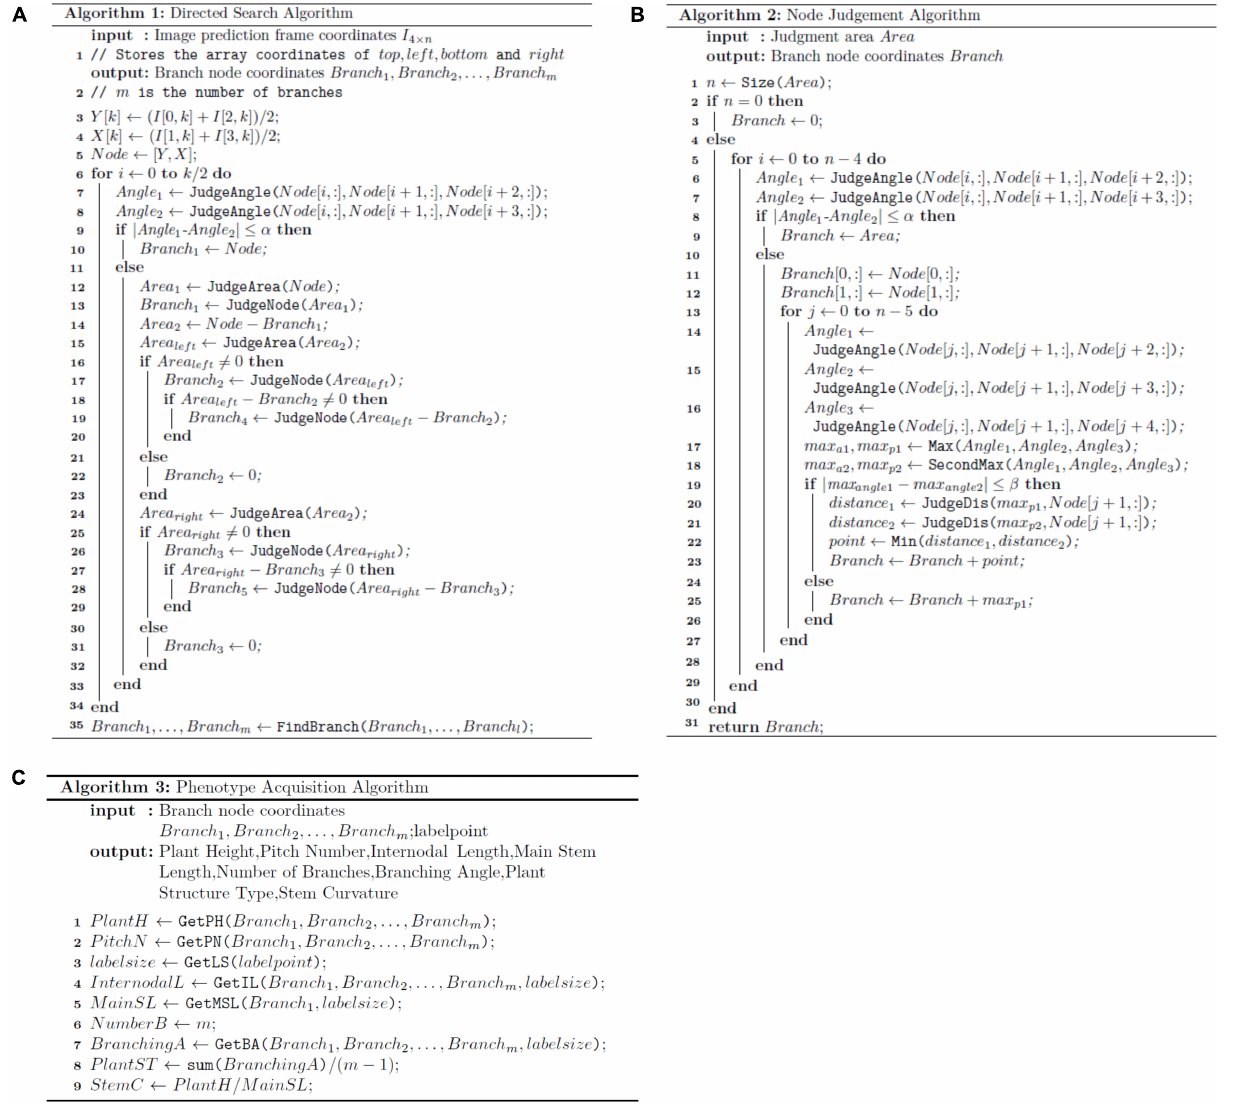
where Area denotes the circled rectangular area, left , top , right , and bottom are the left, top, right, and bottom coordinate values of the rectangular area, respectively, and pixel represents the pixel value needed to increase the width of the rectangular area from left to right. We analyzed the data and